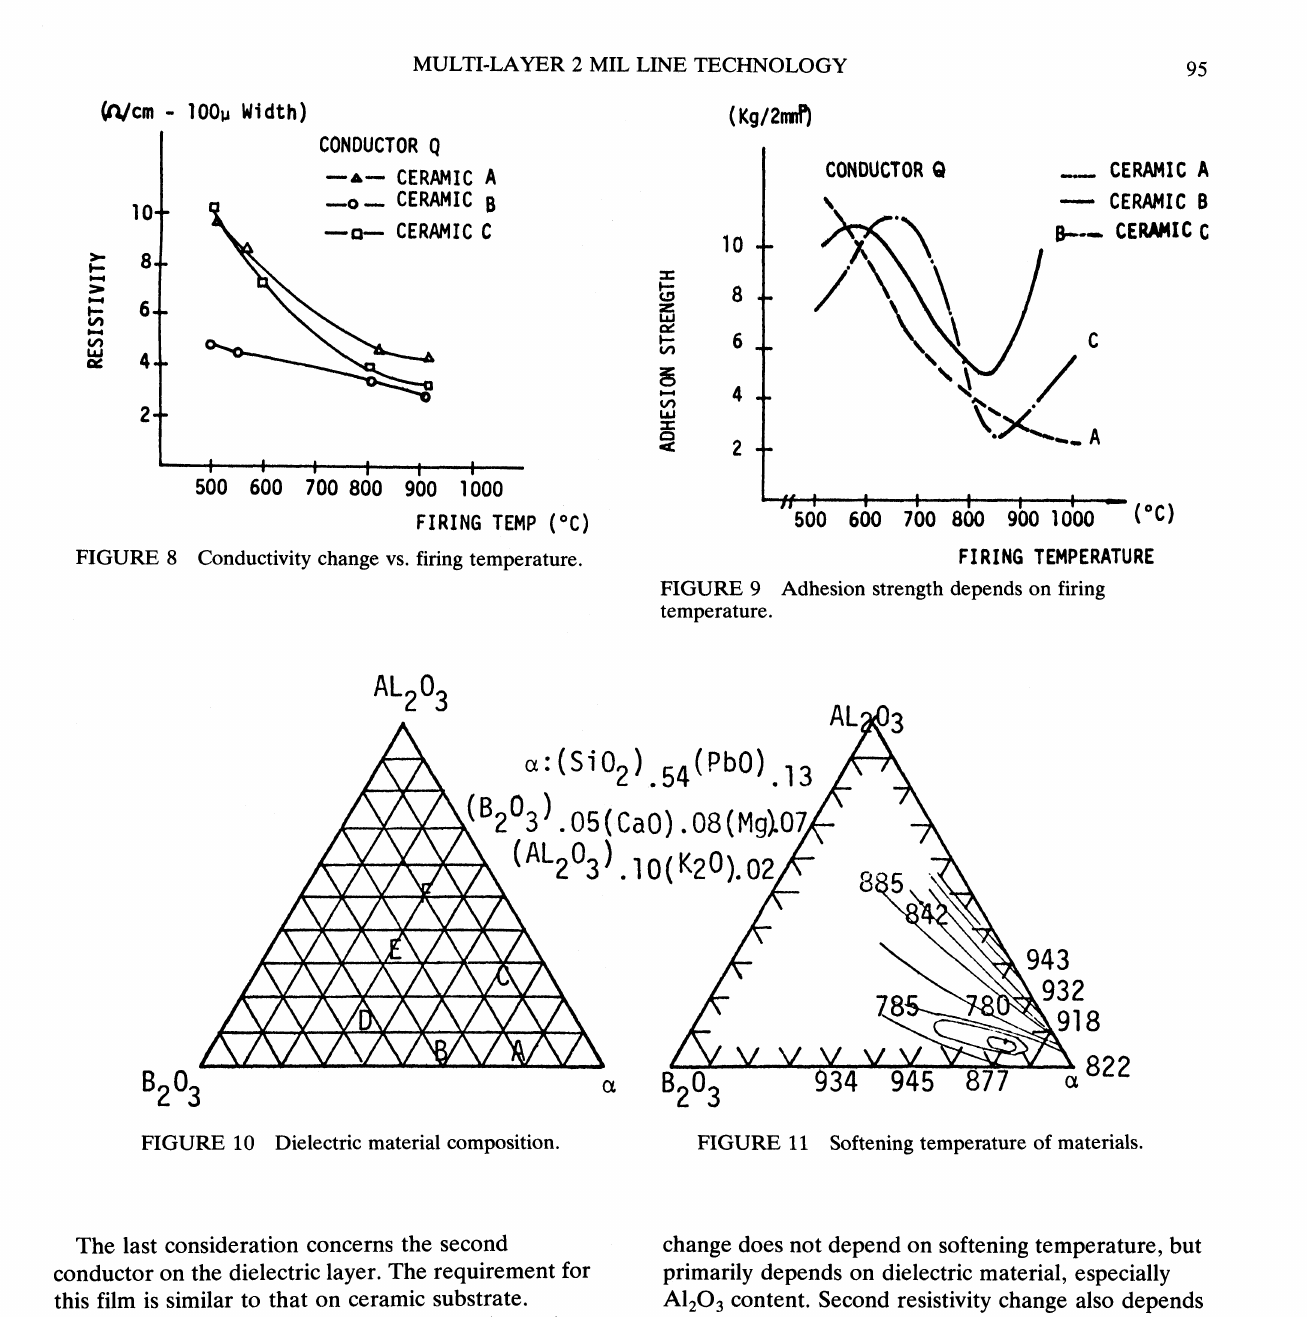
FIGURE 10 Dielectric material composition. FIGURE 11 Softening temperature of